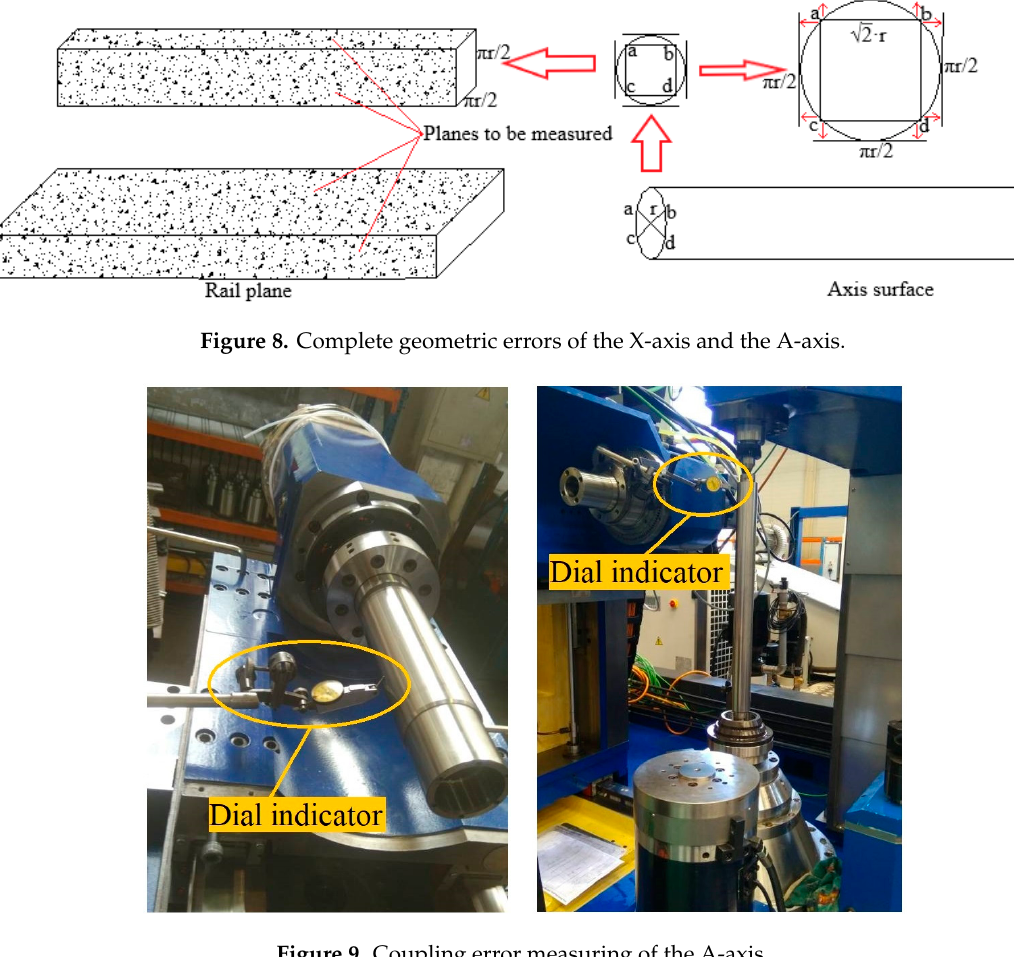
Figure 9. Coupling error measuring of the A-axis.